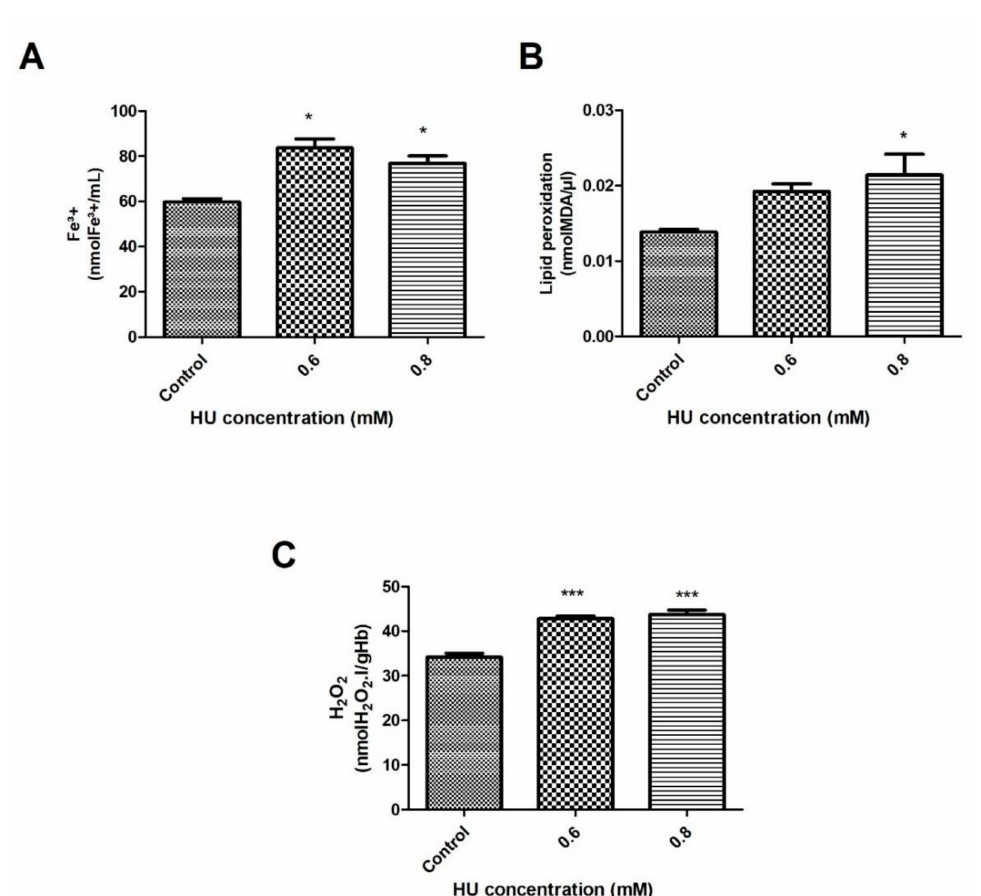
Figure 1. Oxidative stress indicators in the erythrocytes of the control samples that were treated with 0.6 and 0.8 mM HU ( n = 3) for 30 min. ( A ) Fe 3+ was measured in plasma; ( B ) Lipid peroxidation (MDA) was measured in plasma; ( C ) Hydrogen peroxide (H 2 O 2 ) was measured in hemolysate. In all of the cases, * represents a comparison between the controls and the treated groups (* p < 0.05 and *** p <